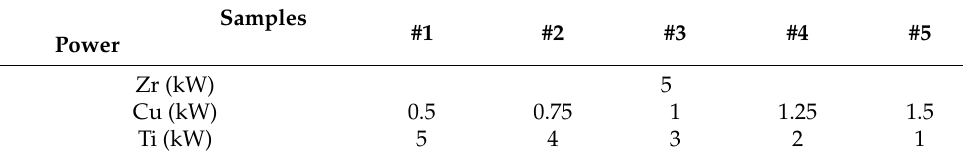
Figure 1. Schematic diagram of experiment apparatus. Table 1. Sample number corresponds to output power of metal targets.